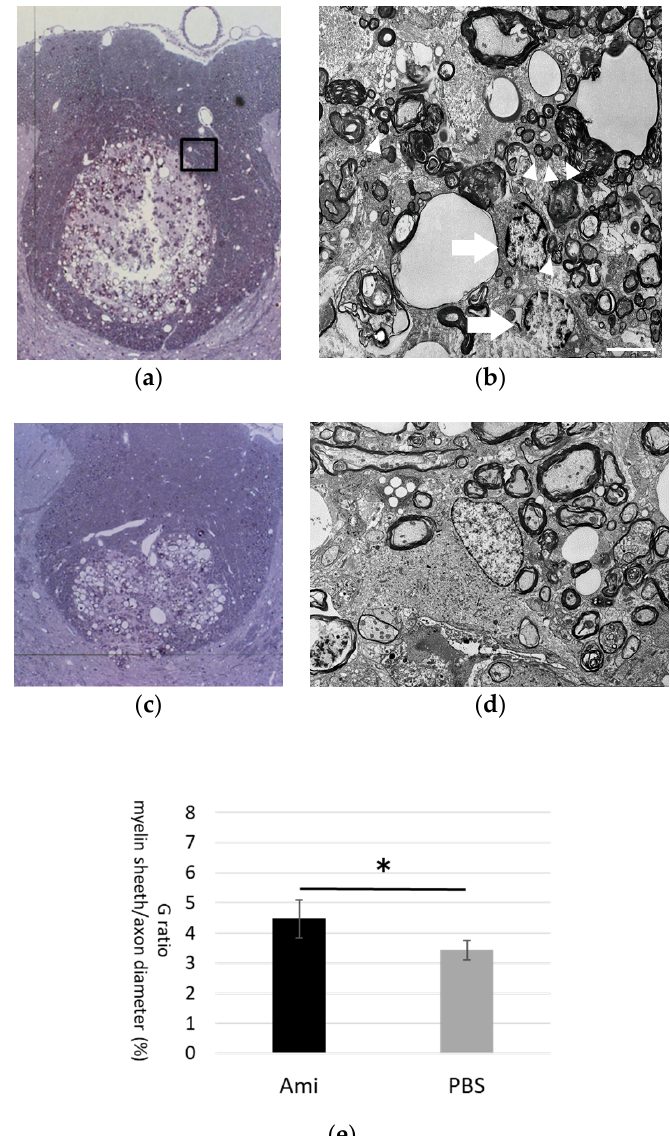
Figure 6. ( a ) Toluidine blue staining of the injured spinal cord from the amiloride group on day 28, with sections taken 7 mm rostral from the epicenter. Electron microscope analysis was conducted on the boxed glial scar area surrounding the epicenter of the lesion; ( b ) Electron microscopy revealed oligodendrocytes (arrows) near the axons (arrowheads) that had smaller diameters compared to axons distant from the injury site (scale bars 5 µm); ( c , d ) PBS group; ( e ) Myelin sheath thickness/axon diameter in the amiloride group was significantly higher than the PBS group at day 28. The asterisk indicates significant difference between the amiloride and PBS groups with a Mann–Whitney U test (* p < 0.05, error bars are standard deviations).